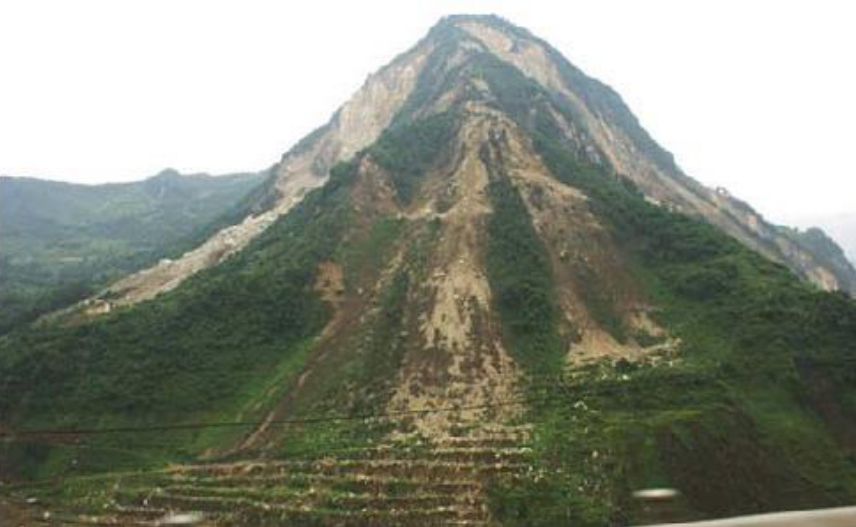
Figure 2. Distribution of landslide points.